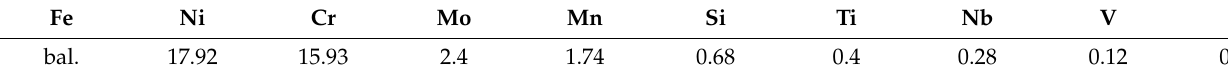
Table 1. Chemical composition of the austenitic reactor steel EK-164 (wt. %).